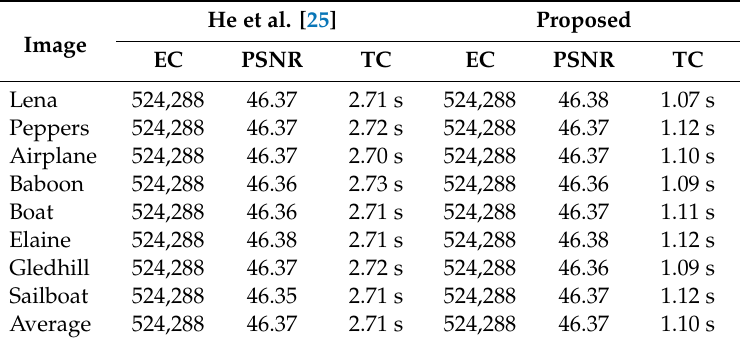
Table 6. Comparison with the mini-SuDoKu matrix-based